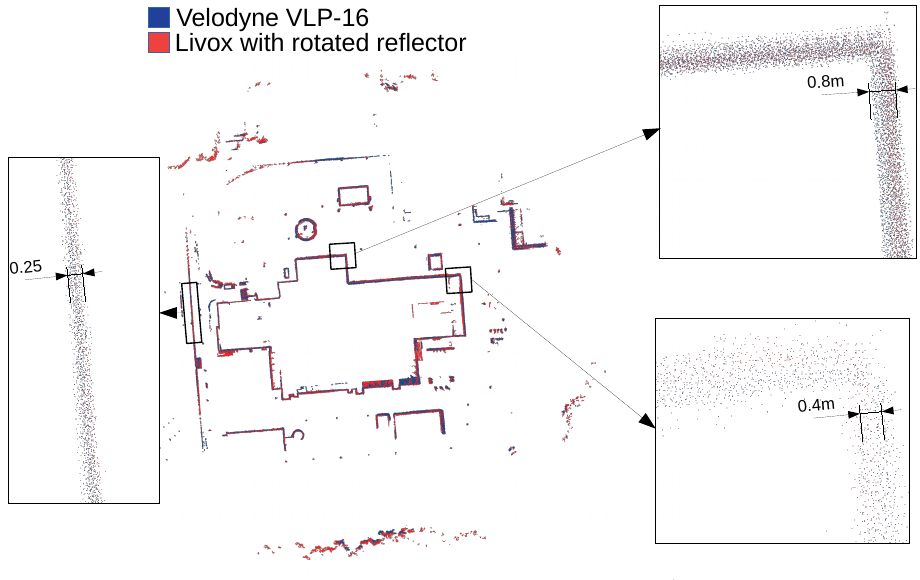
Figure 17. Comparison of the intersection of VLP 16 and Livox Mid–40 with rotated mirror. There is visibly no discrepancy between blue (Velodyne VLP 16) and red (Livox with rotated reflector).